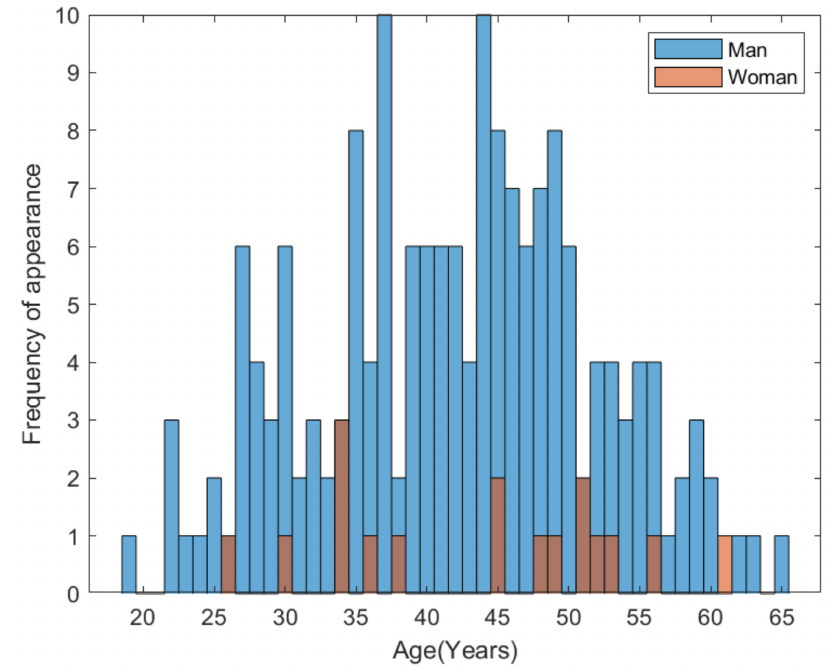
Figure 3. Dependence of age, frequency and